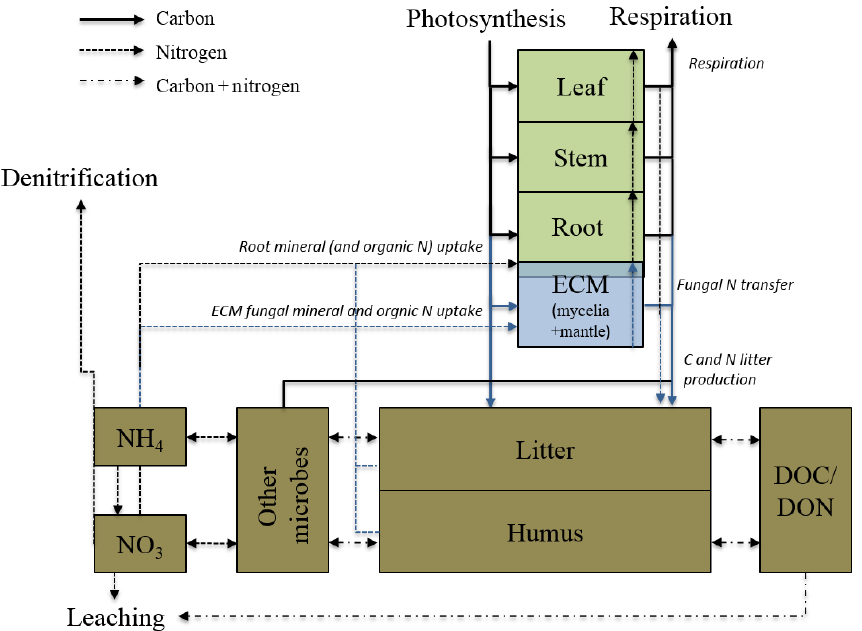
Figure 1. A simplified overview of C and N fluxes among plants, mycorrhiza fungi, and the soil in the Coup-MYCOFON model. Light blue indicates the newly implemented MYCOFON